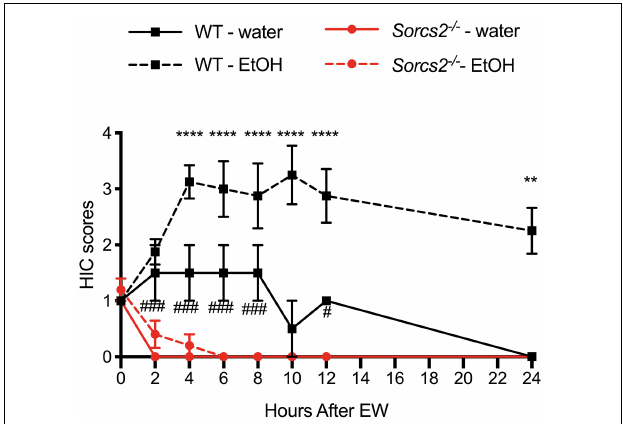
FIGURE 4 | Sorcs2 − / − mice do not display alcohol withdrawal symptoms. For 14 days, the only drinking source for WT and Sorcs2 − / − mice was water containing alcohol, which increased in concentration over time. Control mice, continued to have normal tap water. On day 15, ethanol was withdrawn from the water. Hereafter, the mice were tested for handling-induced convulsion every 2 h after alcohol withdrawal. Sorcs2 − / − mice seemed non-affected by the alcohol and its withdrawal. Accordingly, WT had significantly more severe convulsions ( ∗∗∗∗ P < 0.0001 at 4, 6, 8, 10, 12 and ∗∗ P < 0.01 at 24 h after alcohol withdrawal, compared to Sorcs2 − / − mice). Interestingly, higher level of convulsion was also observed in the WT control group compared to Sorcs2 − / − control group (### P = 0.0001 and # P < 0.01) ( n = 2–3 for each ethanol-naïve group and n = 5–8 for each ethanol-treated group). The results are expressed as mean ± SEM. The error bars in some data points are smaller than the symbols and therefore not visible.